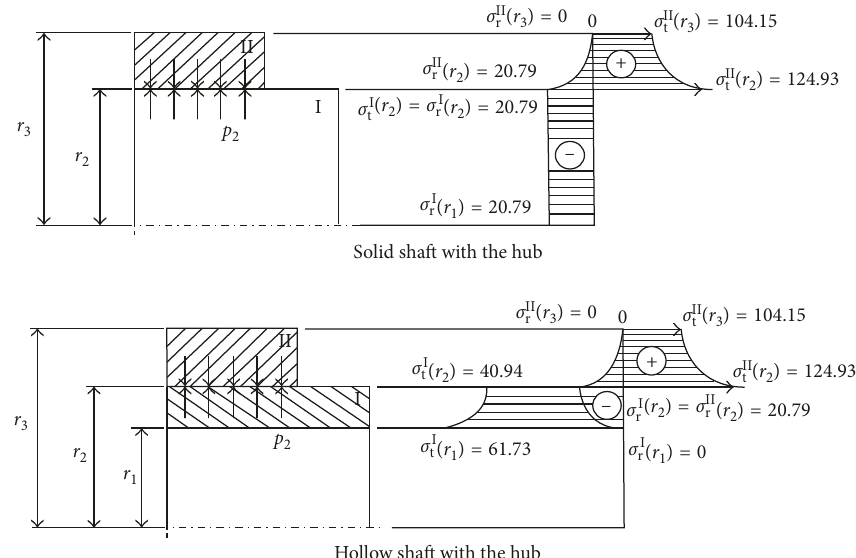
Figure 3: Stress in the solid and the hollow shaft with the hub